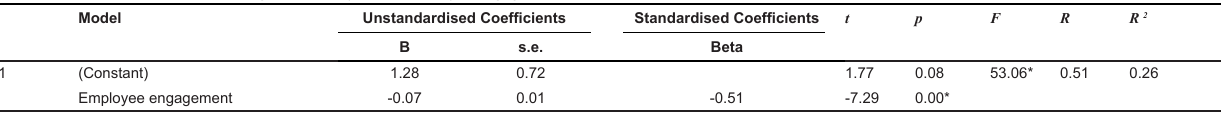
TABLE 4 Multiple regression analysis with employee engagement as independent variable and turnover intention as dependent variable